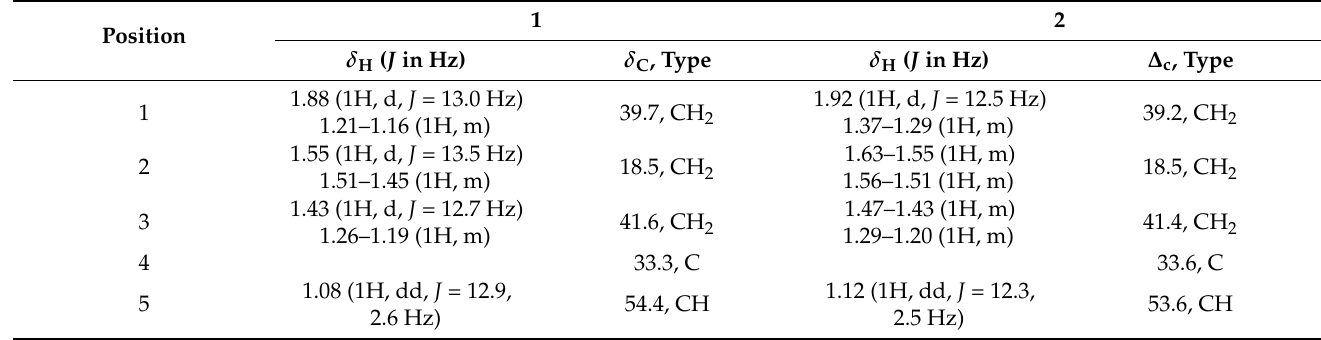
Table 1. 1 H (400 MHz) and 13 C (100 MHz) NMR data for 1 and 2 in CDCl 3 .